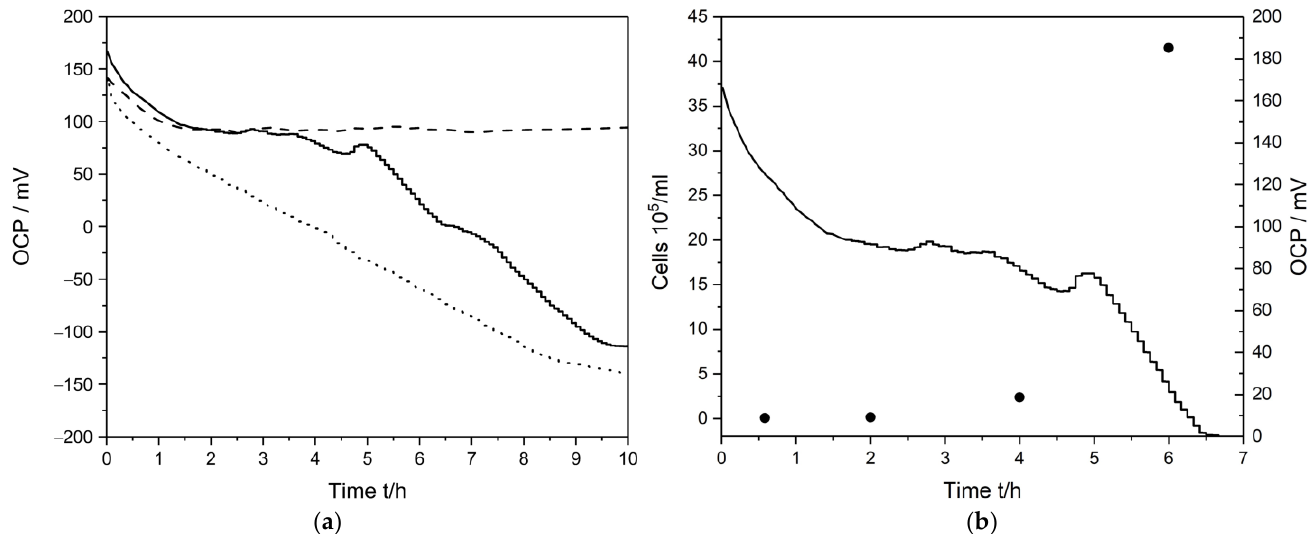
Figure 3. ( a ) Measurement of bacteria in AUM in which 2 µL (solid); 200 µL (dotted) or no (dashed) bacterial aliquot was added after 30 min; ( b ) Quantification of the bacteria with flow cytometry (solid circles, left y-axis) at 0, 2, 4, 6 h in relation to the measured OCP upon addition of a 2 µL bacterial aliquot (right y-axis).